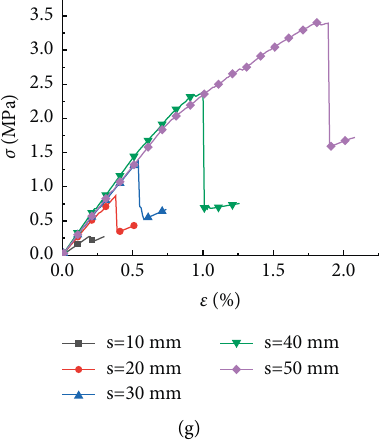
Figure 1: Stress-strain curves of rocks of different sizes. (a) l � 100mm, (b) l � 200mm, (c) l � 400mm, (d) l � 600mm, (e) l � 800mm, (f) l � 1000mm, and (g) l �